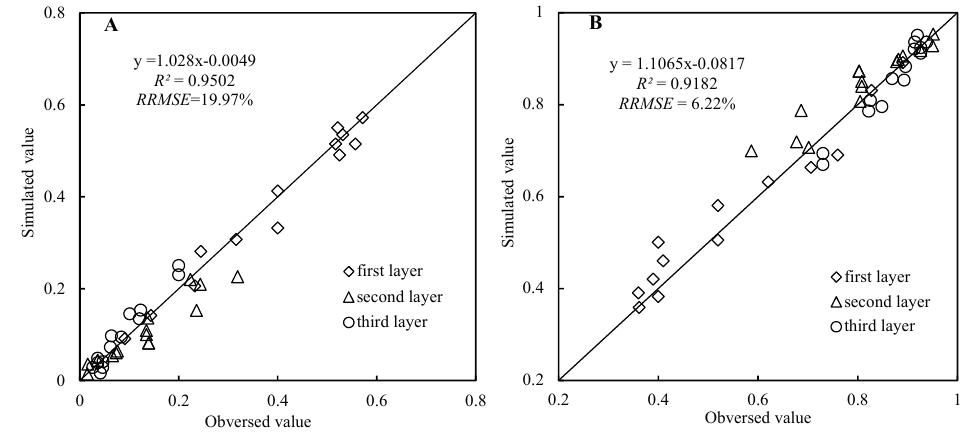
Figure 12. Comparison of simulated and observed PAR transmittance and interception values. ( A ) Transmittance and ( B )